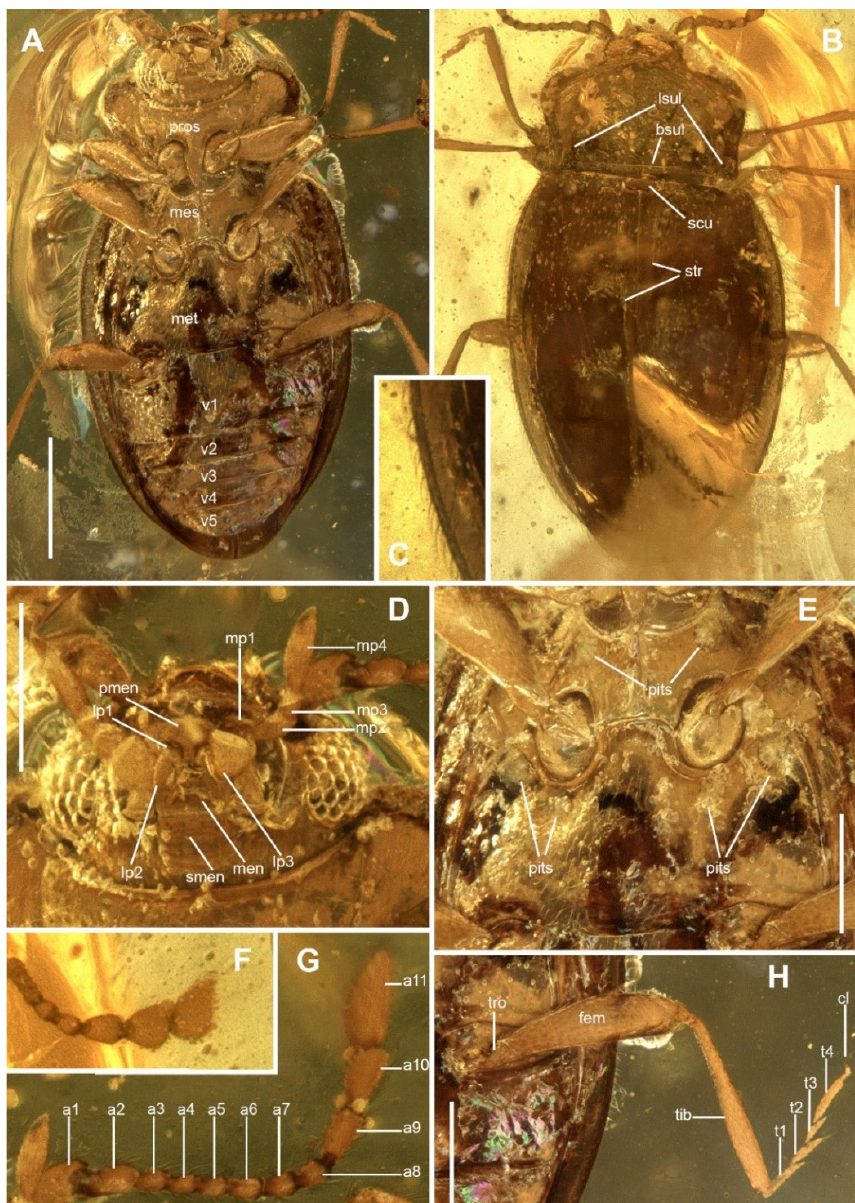
Figure 2. Cretostenotarsus striatus sp. nov., holotype, MAIG 5999. ( A ), habitus, ventral. ( B ), habitus, dorsal. ( C ), detail of lateral margin of elytra with setae. ( D ), head and mouthparts, ventral. ( E ), meso- and metaventrite, ventral. F, antennal club, dorsal. ( G ), antenna, ventral. ( H ), hind leg. Abbreviations: a1–a10, antennomeres; bsul, basal sulcus; cl, tarsal claw; fem, femur; lp1–lp3, labial palpomeres; lsul, lateral sulci; men, mentum; mes, mesoventrite; met, metaventrite; mo1–mp4, maxillary palpomeres; pment, prementum; pros, prosternum; smen, submentum; str, sutural striae; t1–t4, tarsomeres; tib, tibia; tro, trochanter; v1–v5, ventrites. Scale bars represent: 500 µm ( A ); 250 µm ( D , E , H ). Moreover, Cretostenotarsus can be distinguished from the genus Danae Reiche,